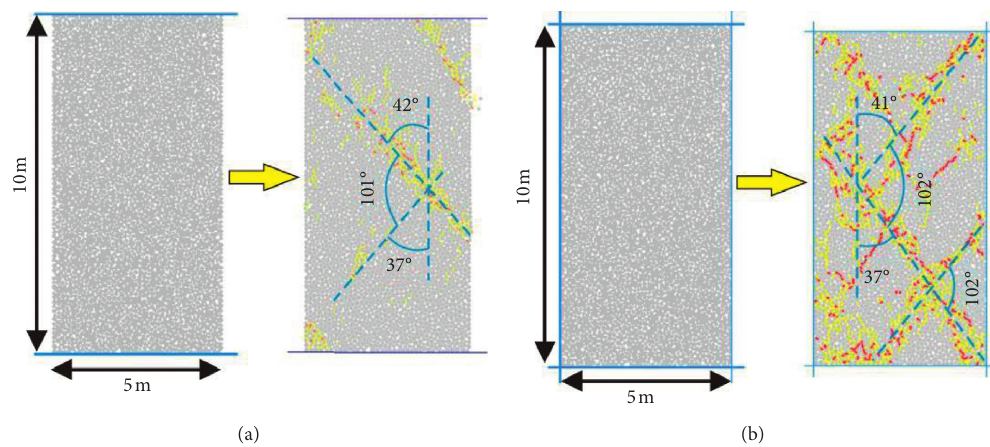
Figure 16: Results of (a) uniaxial compression testing and (b) biaxial loading and unloading testing of 4-2